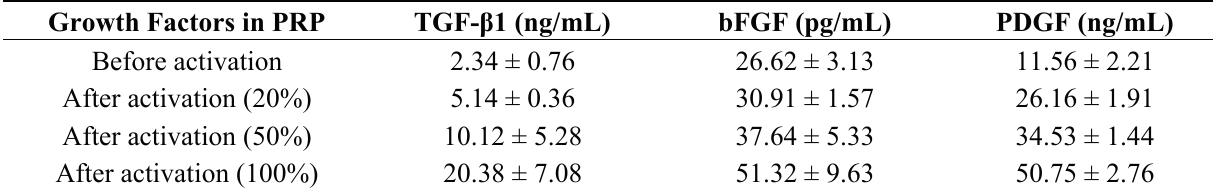
Figure 6. The immunofluorescence staining of type II collagen of SF-MSCs among 0% ( A ); 20% ( B ); and 50% PRP ( C ). The increased secretion of type II collagen was accompanied by the increase of PRP concentration. Green: type II collagen; blue: nuclei. Table 1. Concentrations of growth factors in PRP. Three PRP samples were performed for this